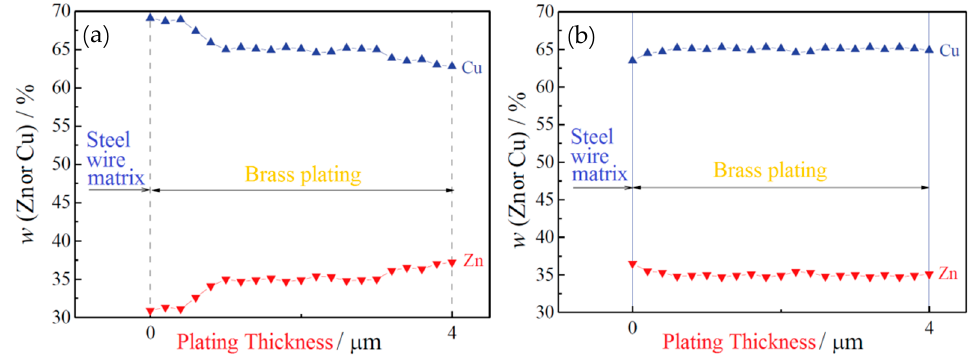
Figure 20. EDX line scans results for ( a ) electroplated and ( b ) hot-dip plated brass coating on steel wires. Reprinted with permission from ref. [36].